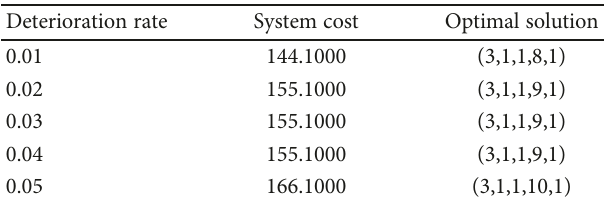
Figure 5: System cost versus simulation times in the Table 6: Optimal solutions for di ff erent deterioration rates in the UCOM.